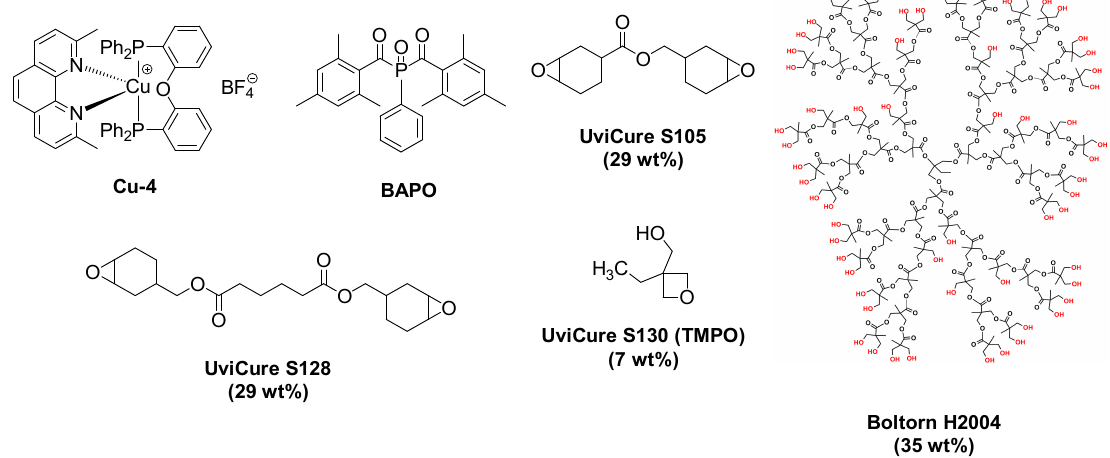
Figure 21. Chemical structures of monomers used in industries.